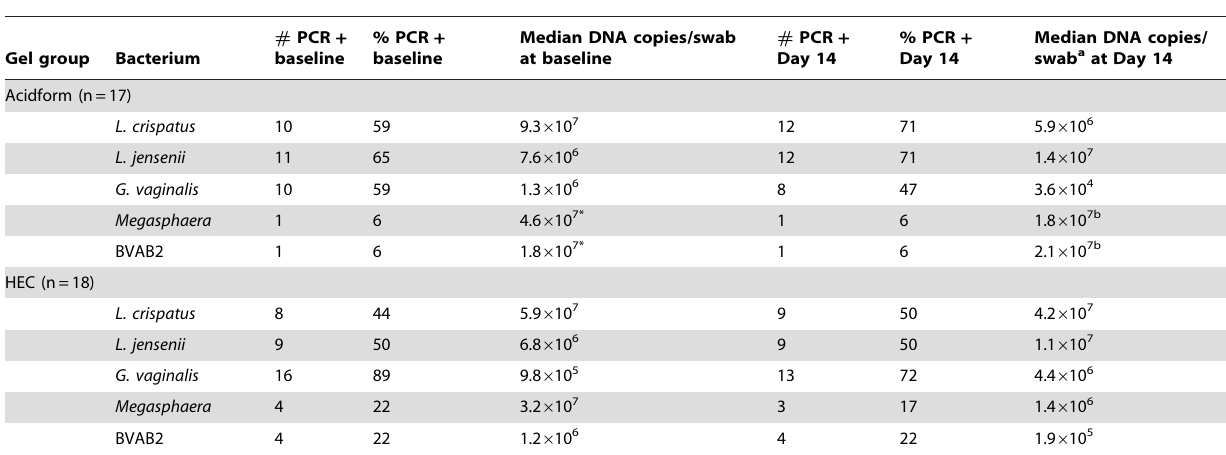
Table 4. qPCR levels of bacteria from swabs collected at baseline (Day 0) and after 14 days of twice daily application of Acidform or HEC gel.